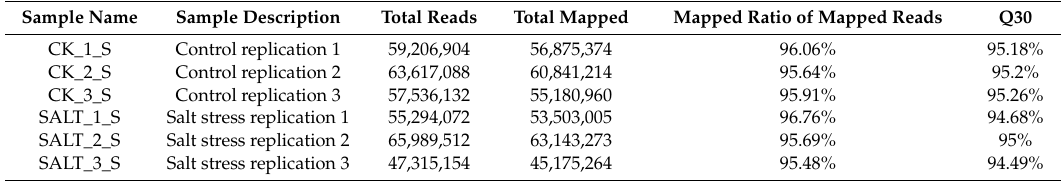
Table 1. Summary of mapping transcriptome reads to reference